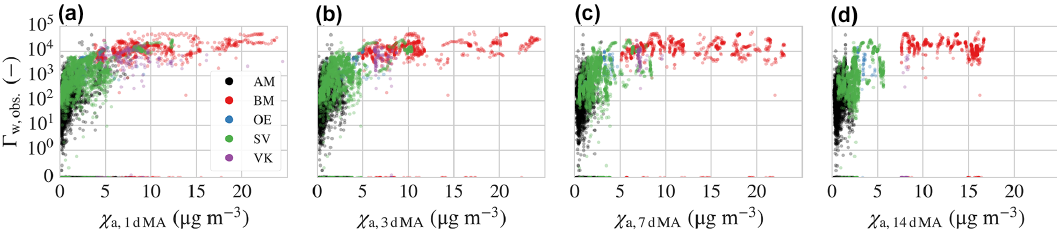
Figure 6. Non-stomatal emission potentials inferred from measurements ( (cid:48) w ) as a function of backward-looking moving averages of mea- sured air ammonia concentrations ( χ a ) . (a) 1 day, (b) 3 day, (c) 7 day, (d) 14 day moving window. Periods with substantial precipitation were removed from the analysis.